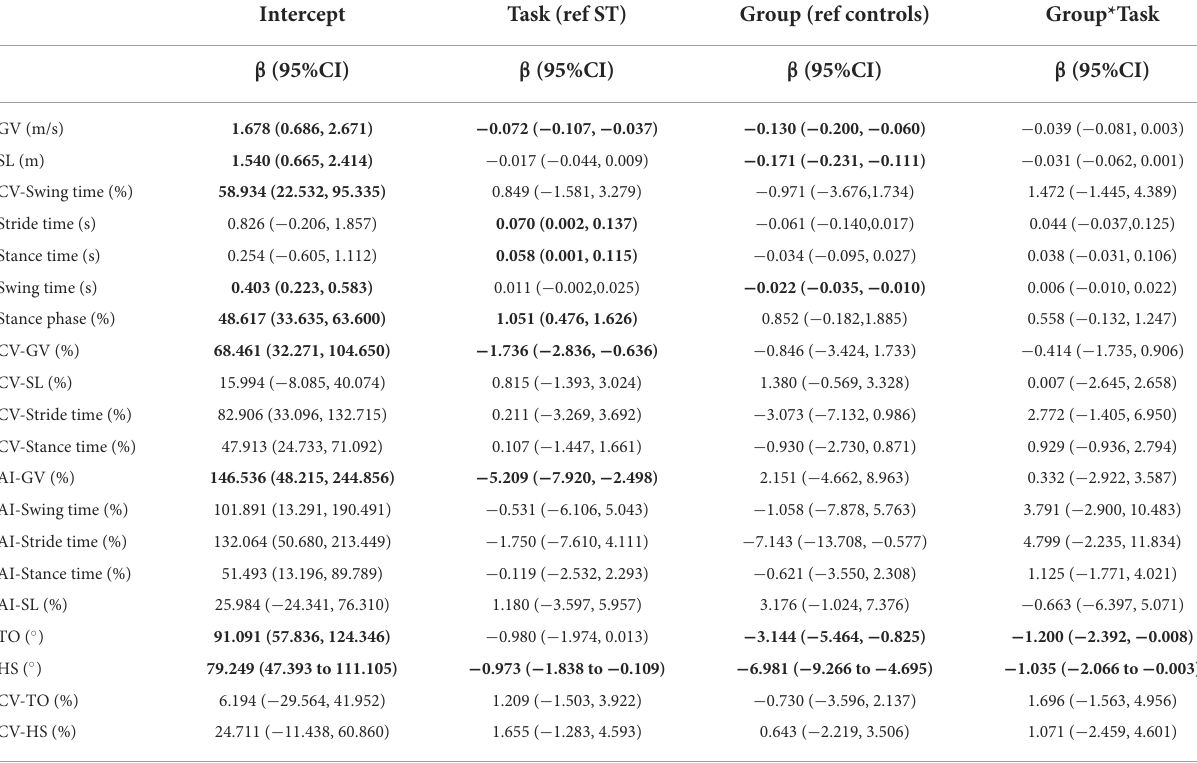
TABLE 5 Results from the generalized linear mixed models for each gait parameter not controlling for gait